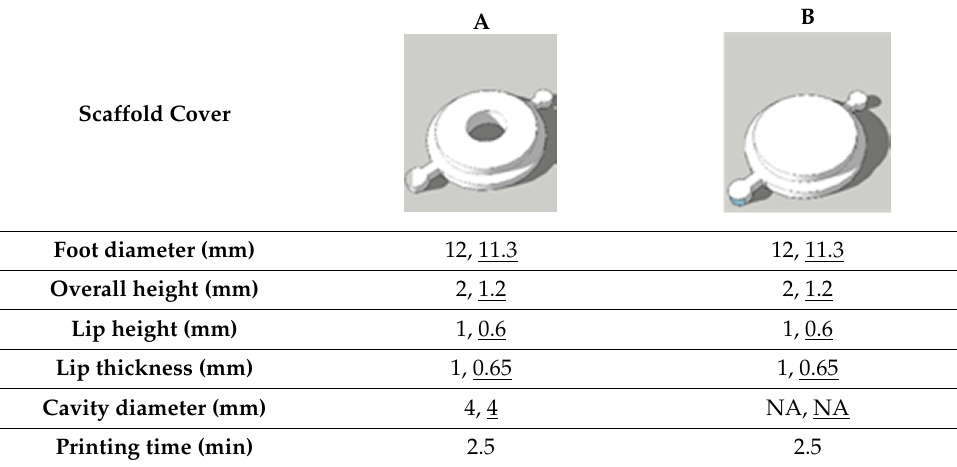
Table 2. Geometry of virtual PLA and PVOH-based scaffold covers used to print physical scaffold covers. Measurements for PVOH – based scaffolds have been underlined. A and B refers to the two different (open or closed) lids.